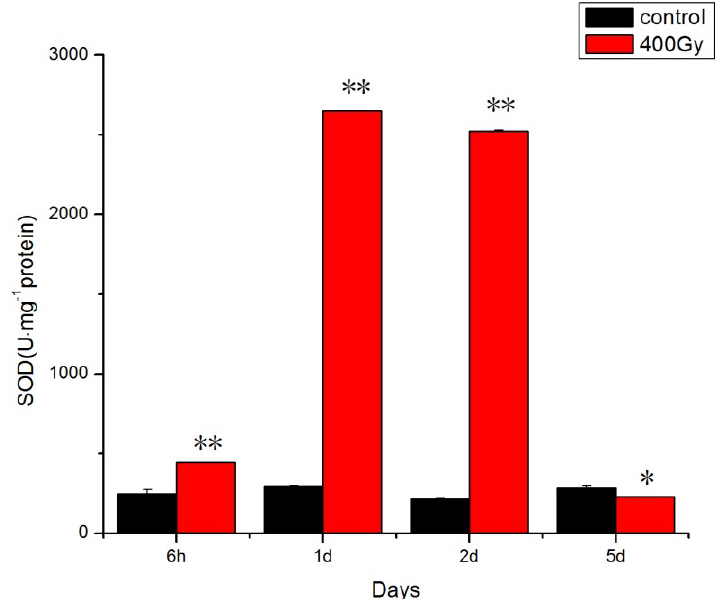
Figure 1. Effects of 60 Co- γ irradiation on SOD activity of P. citri adults for different lengths of time. Values are mean ± SD ( n = 3). Asterisk designates statistically significant difference between control and irradiated adults (** p < 0.01; * p <